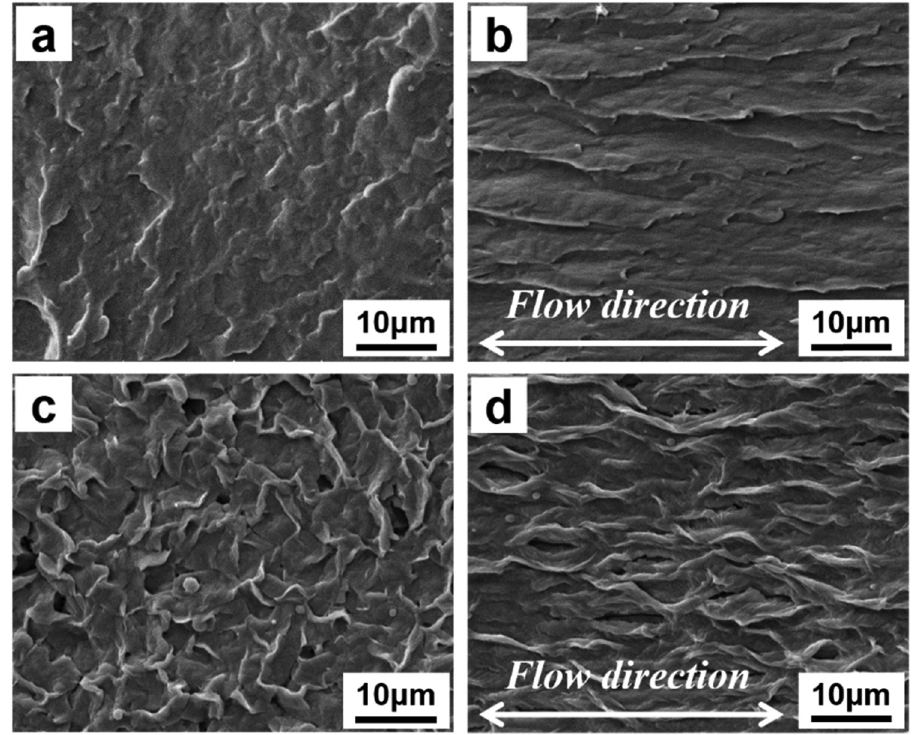
Figure 2: The cryo - fracture surfaces of ( a ) neat PBS and ( c ) PIF PBS; crystal morphology of ( b ) neat PBS and ( d ) PIF